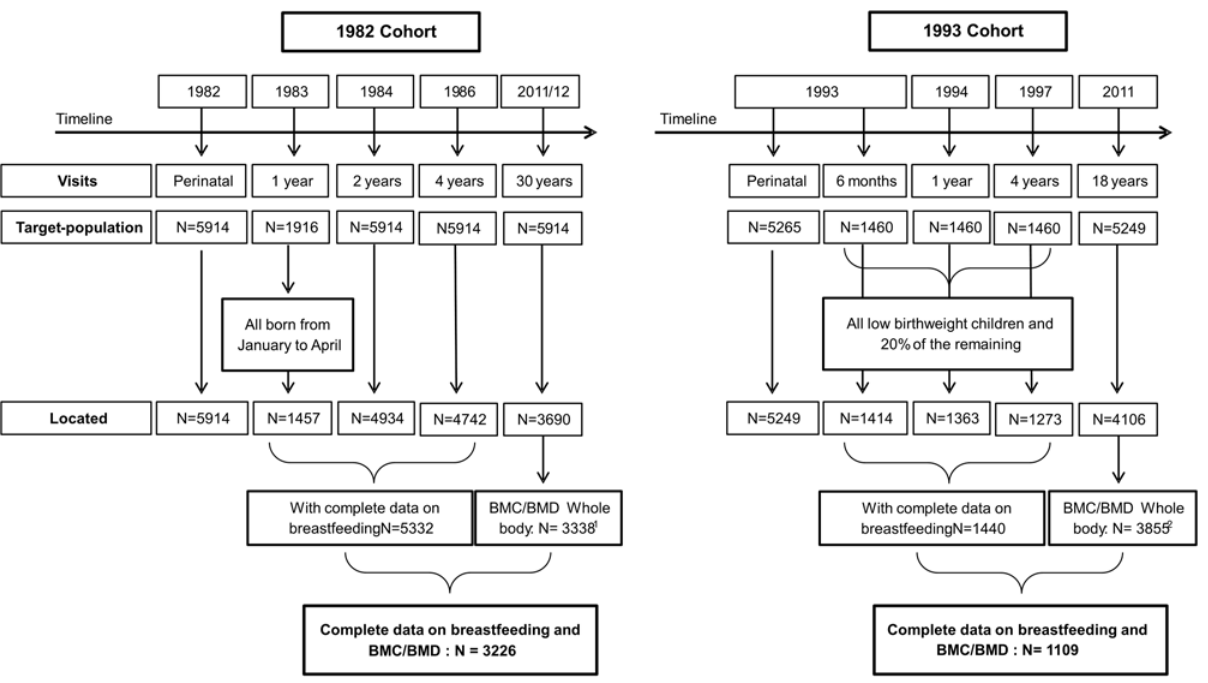
Fig 1. Description of the 1982 and 1993 Pelotas Birth Cohorts. 1 Subjects excluded of DXA scan: pregnant or suspected pregnancy (n = 72); individuals in wheelchairs or with osteo-articular disabilities (n = 5); losses/refusals or subjects with wearing non-removable metallic objects (e.g. screws, earrings or piercings) or extremely obese individuals or those taller than 192 cm (n = 275); 2 Subjects excluded of DXA scan: pregnant or suspected pregnancy (n = 60); individuals in wheelchairs or with osteo-articular disabilities (n = 11); losses (n = 10); subjects with wearing non-removable metallic objects (e.g. screws, earrings or piercings) or extremely obese individuals or those taller than 192 cm (n =